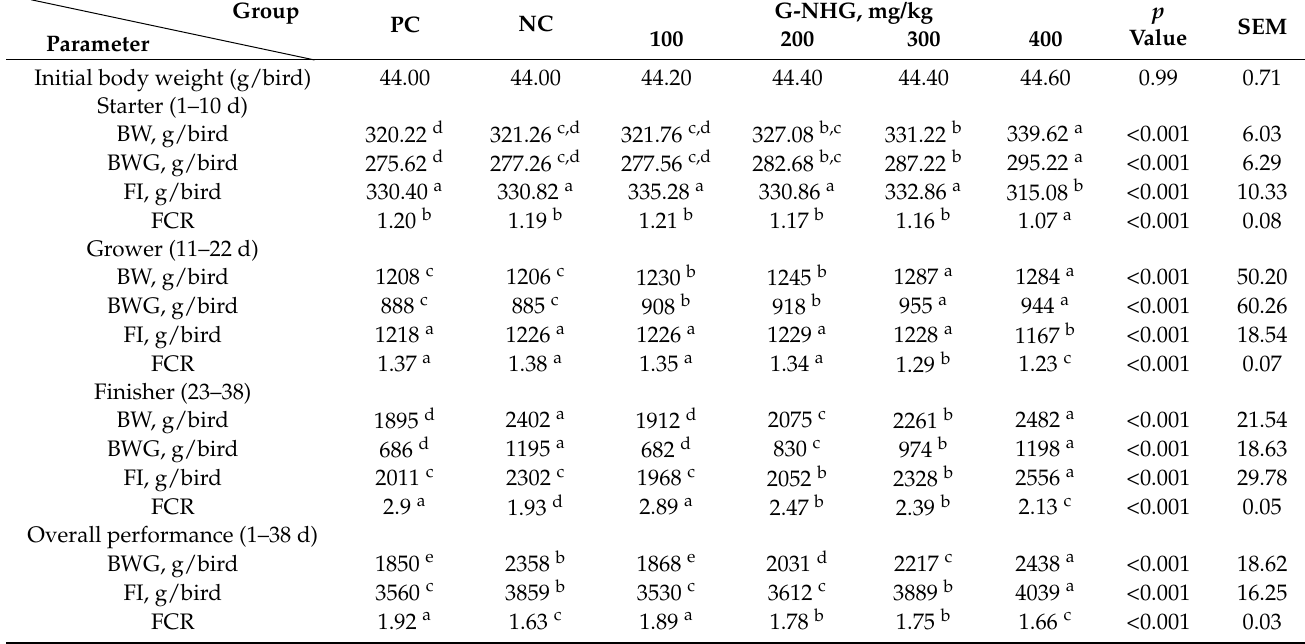
Table 3. Effect of feeding different levels of G-NHG on the growth performance of broiler chickens challenged with C.